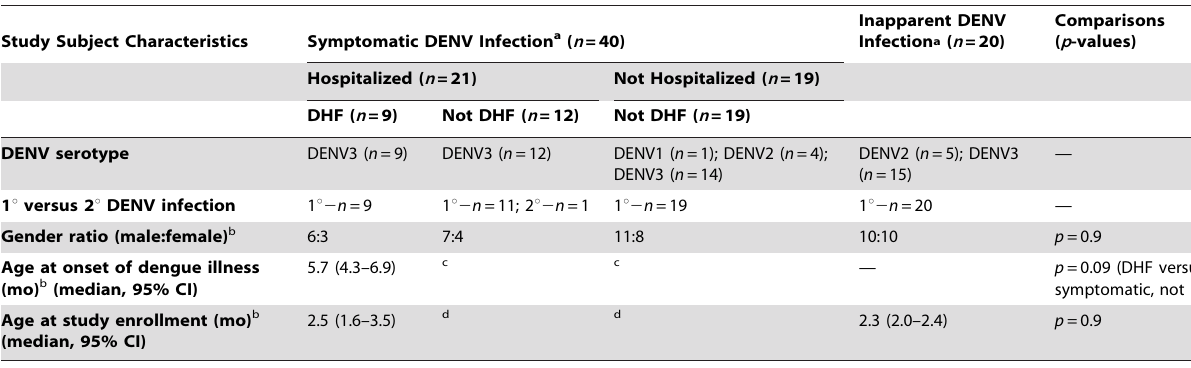
Table 1. Study subject characteristics.